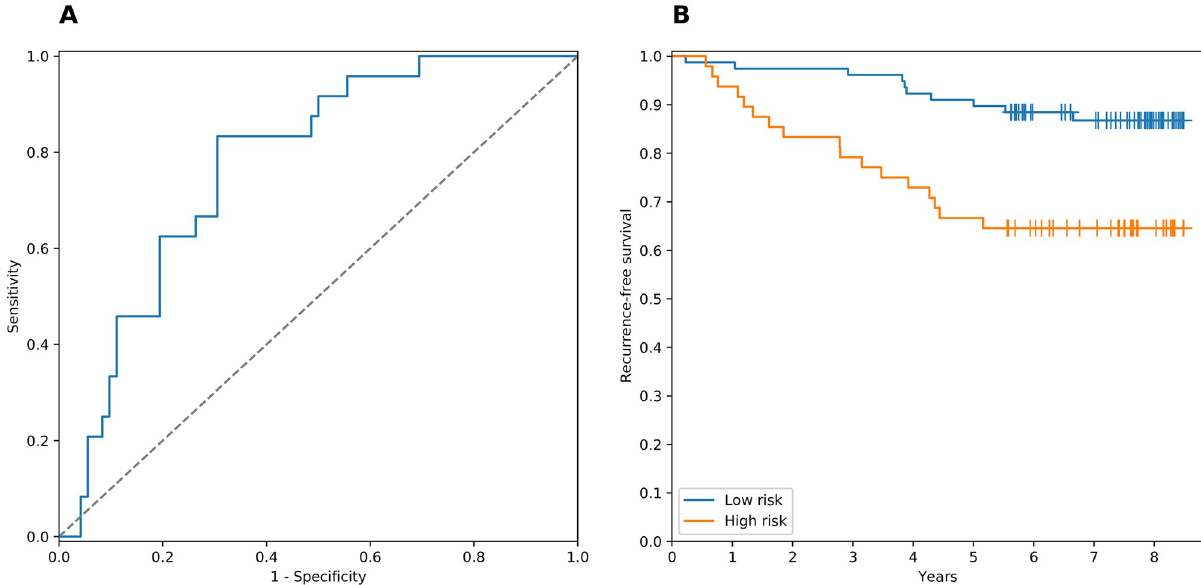
Fig 5. Performance of the eight-gene signature on the validation set (GSE1456). (A) ROC curve (AUC = 0.78). (B) Kaplan-Meier plot (logrank test p =